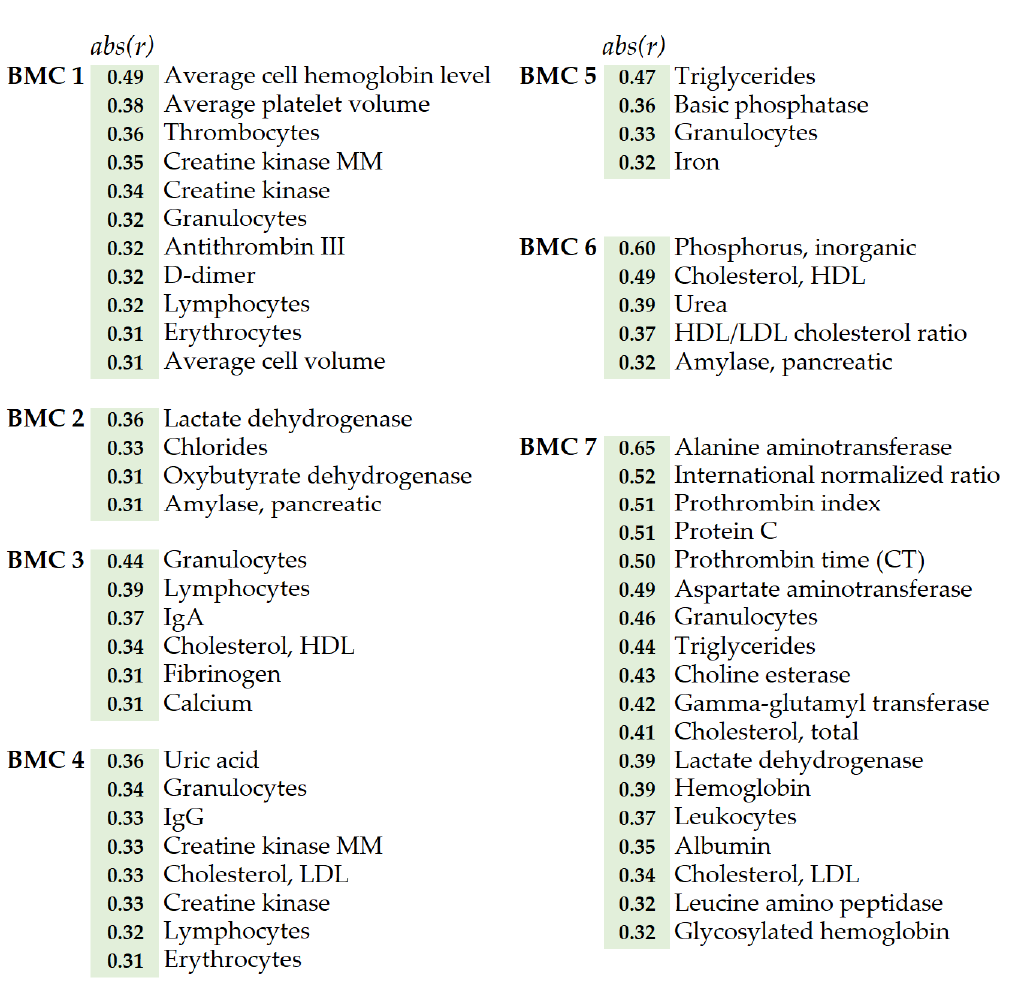
Figure 5. Correlation of the blood metabogram components with the clinical blood tests. Only moderate and strong correlations are presented. Full data are presented in Figure S1. Abs ( r) —absolute value of correlation coefficient r (demonstrates the strength of the connection between clinical test and BMC). BMC—blood metabolome component.